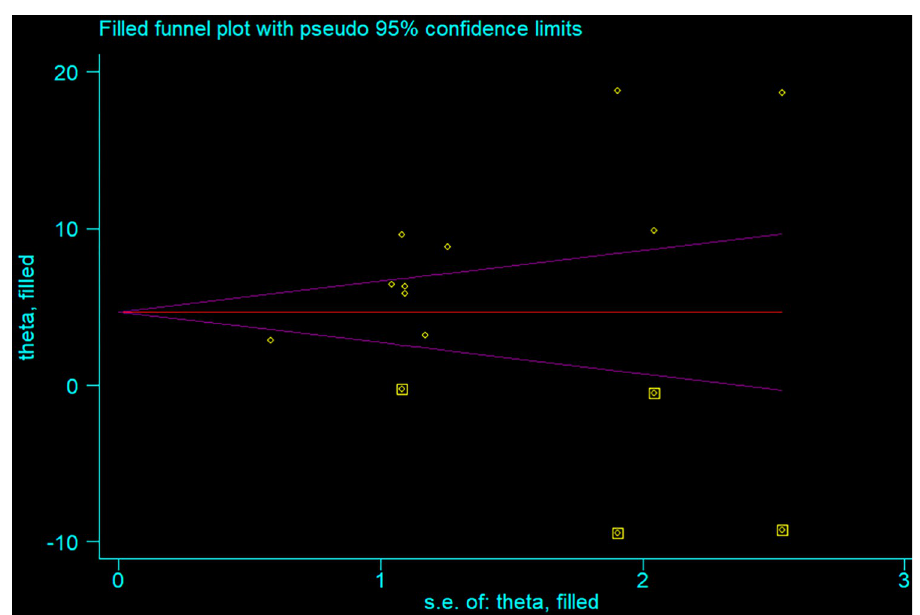
Fig 4. Funnel plot with 95% confidence limit of a simulated meta-analysis containing 14 studies.